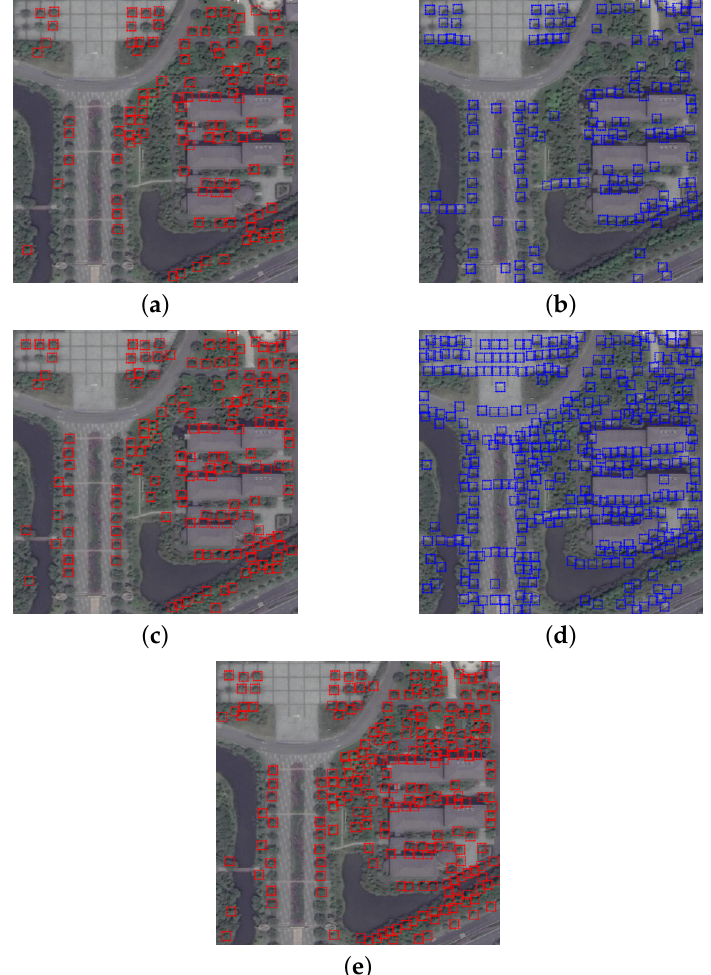
Figure 13. Results for different classification branches in Test Area 2 (window size 26 × 26): ( a ) Positive samples received in Branch 1; ( b ) Negative samples removed in Branch 1; ( c ) Positive samples received in Branch 2; ( d ) Negative samples removed in Branch 2; and ( e ) Positive samples received in Branch